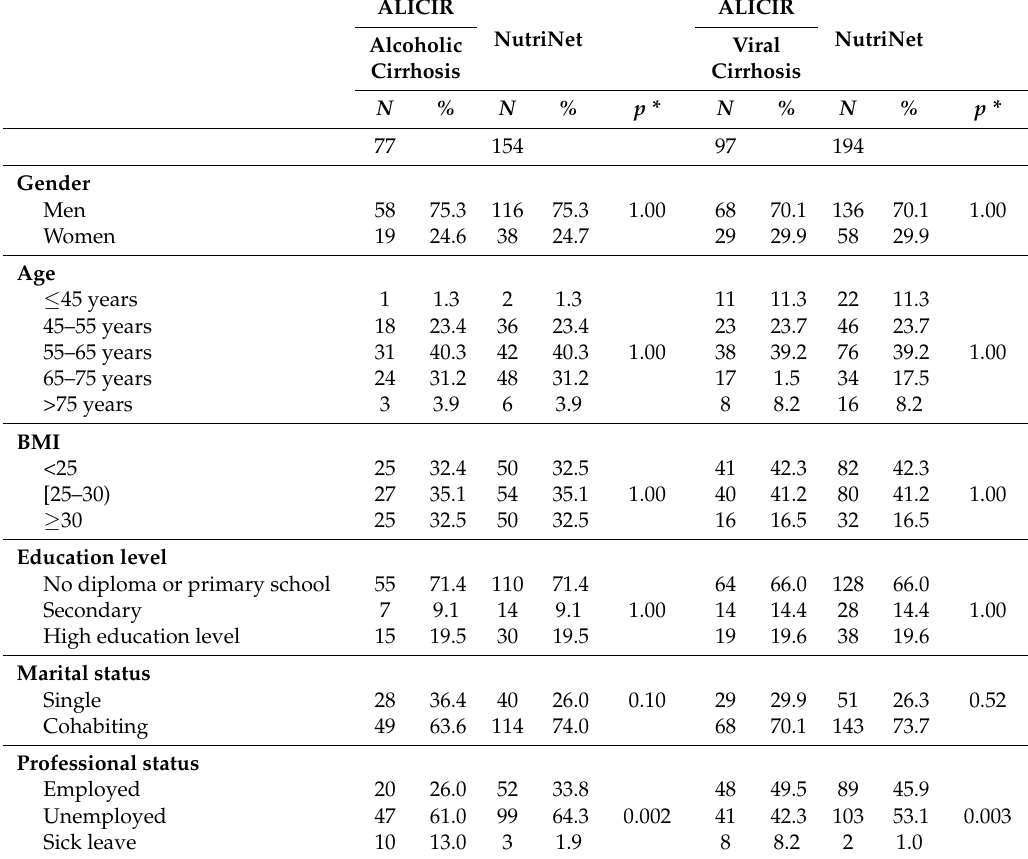
Table 2. Comparison of sociodemographic characteristics for cases and controls stratified on the aetiology of cirrhosis ( N =